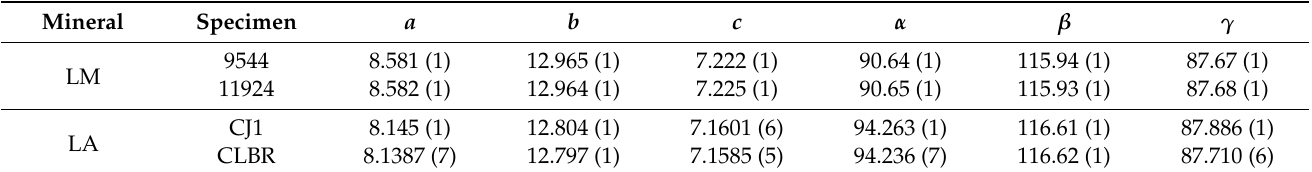
Table 10. Cell parameters of the selected specimens of alkali feldspar acquired by Rietveld refinement; two consist of the “X-ray low microcline” variant of K-feldspar (LM), and two consist of the “X-ray low albite” variant of Na-feldspar (LA), in Å for the cell dimensions and degrees for the cell angles.